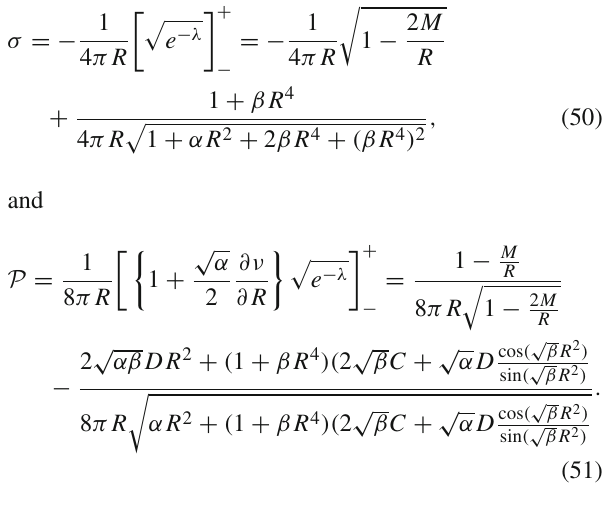
Table 1. Now we will discuss the conditions which are